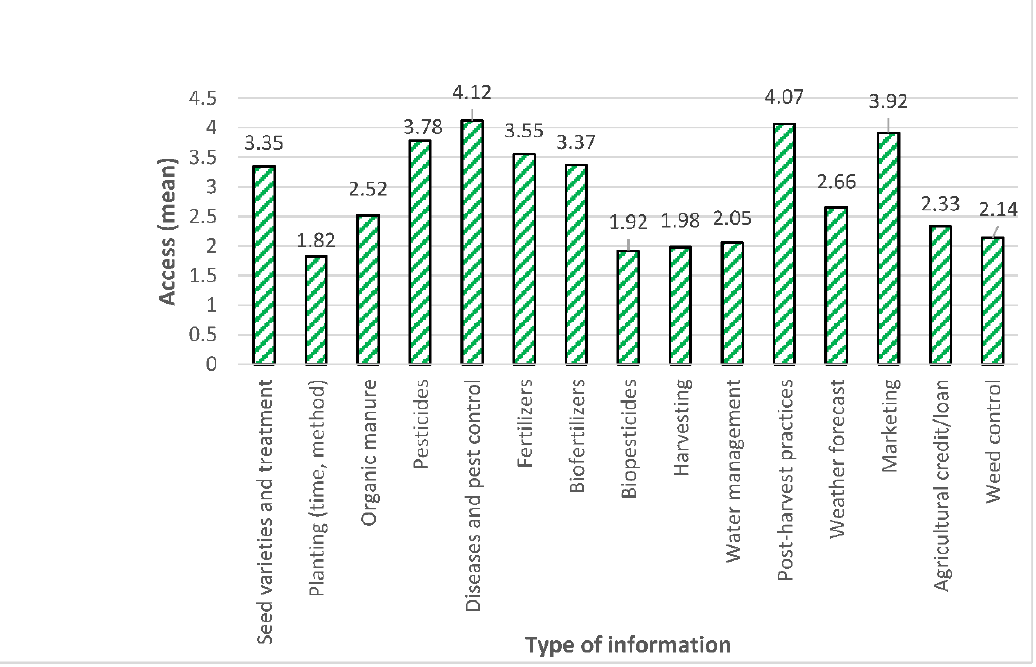
Figure 2. Types of information accessed by farmers.